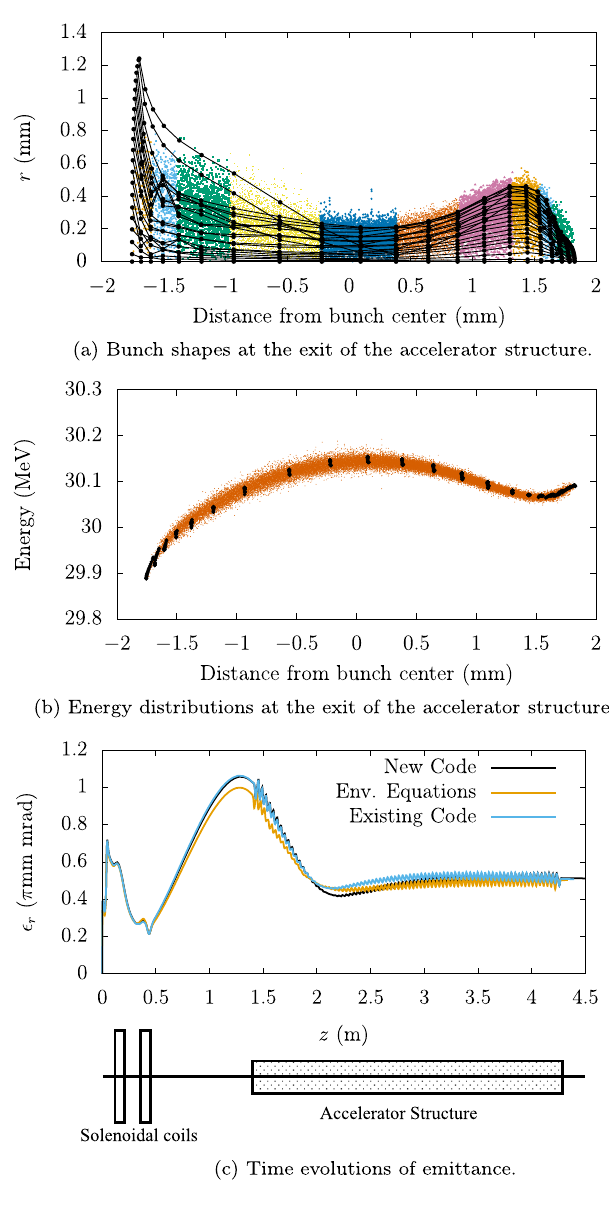
FIG. 12. Beam dynamics for the SPring-8 rf gun injector system with focusing fields calculated by the new